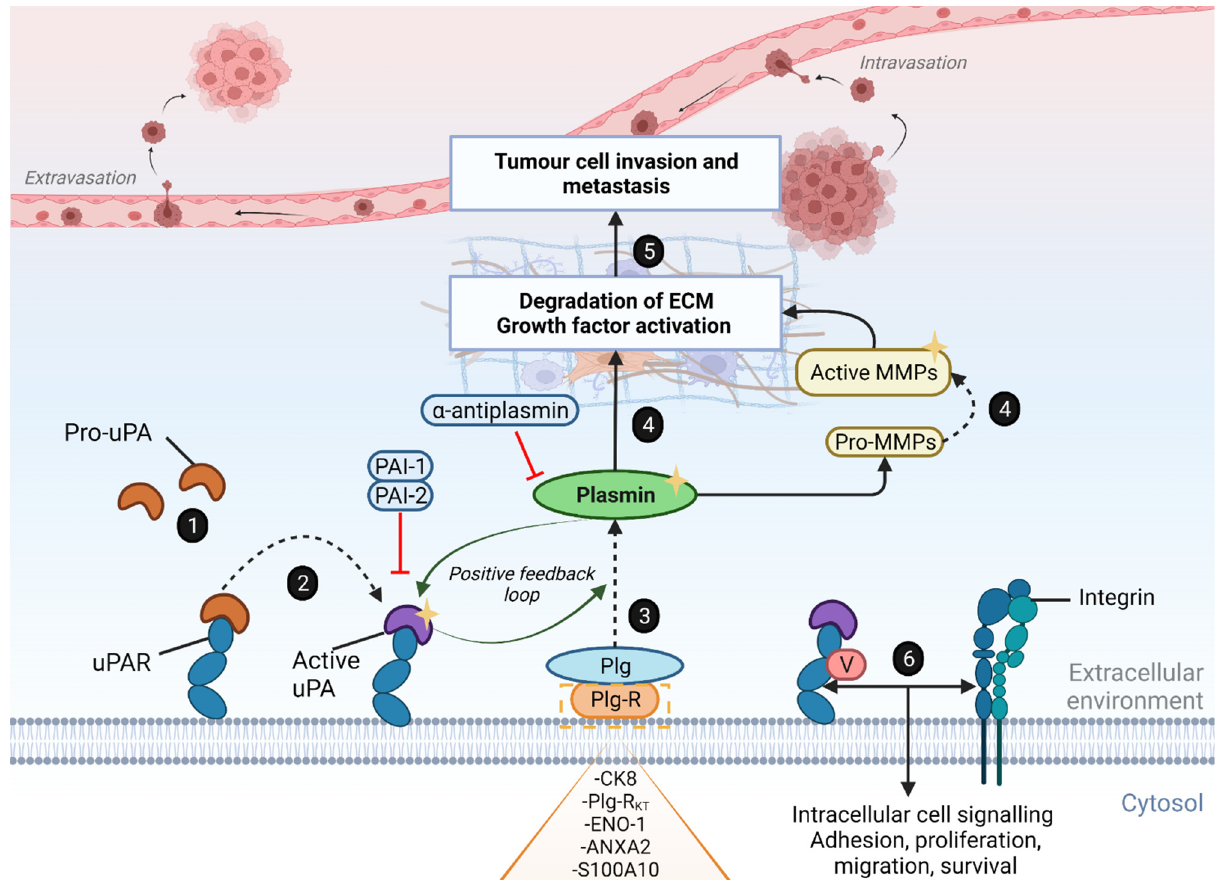
Figure 3. Schematic of the Urokinase Plasminogen Activator (uPA) System. Pro-uPA binds to the uPA cell surface receptor (uPAR) ( 1 ) and activates pro-uPA into active uPA ( 2 ). Plasminogen (Plg) binds to its receptor (Plg-R; which include, but are not limited to, the well-characterised plasminogen receptors cytokeratin 8 (CK8), plasminogen receptor KT (Plg-R KT ), alpha-enolase (ENO1) and annexin 2 (ANXA2) or S100A10), and is cleaved by uPA to elicit the active serine protease plasmin ( 3 ). Co- localised plasmin, in turn, activates a positive feedback loop generating more uPA and plasmin. The proteolytic activities of uPA and plasmin are inhibited by the serpins plasminogen activator inhibitor-1 (PAI-1; also known as SerpinE1), and PAI-2 (also known as SerpinB2) and α 2-antiplasmin. Plasmin mediates its proteolytic effects directly on extracellular matrix (ECM) components and through the activation of multiple downstream ECM-associated proteins, including latent growth factors and matrix metalloproteinases (MMP’s), to degrade the ECM ( 4 ). The degraded matrix provides a path for the migration of cancerous cells to surrounding tissue, facilitating cell migration, invasion, angiogenesis and metastasis ( 5 ). uPAR binds to vitronectin (V) and interacts with other co- receptors, such as integrins, to activate intracellular signalling that promotes tumour cell proliferation, adhesion, migration, invasion, epithelial-mesenchymal-transition (EMT) and survival ( 6 ). Created with BioRender.com (accessed on 15 November